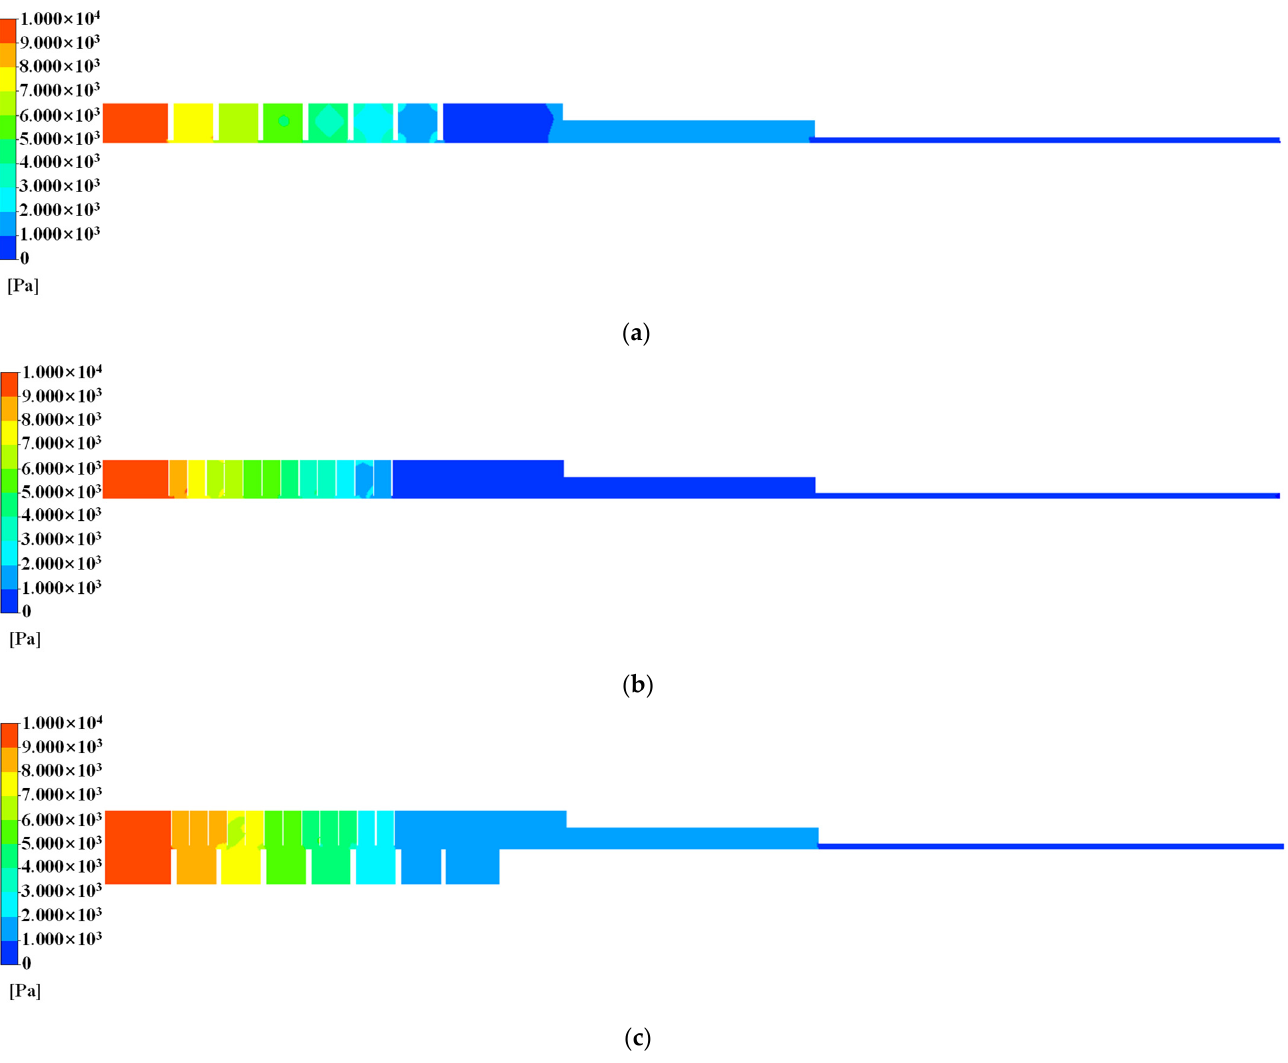
Figure 5. Pressure distribution diagram of three types of seals (RE = 0 mm). ( a ) Labyrinth seal; ( b ) honeycomb seal; ( c ) hybrid labyrinth–honeycomb seal.